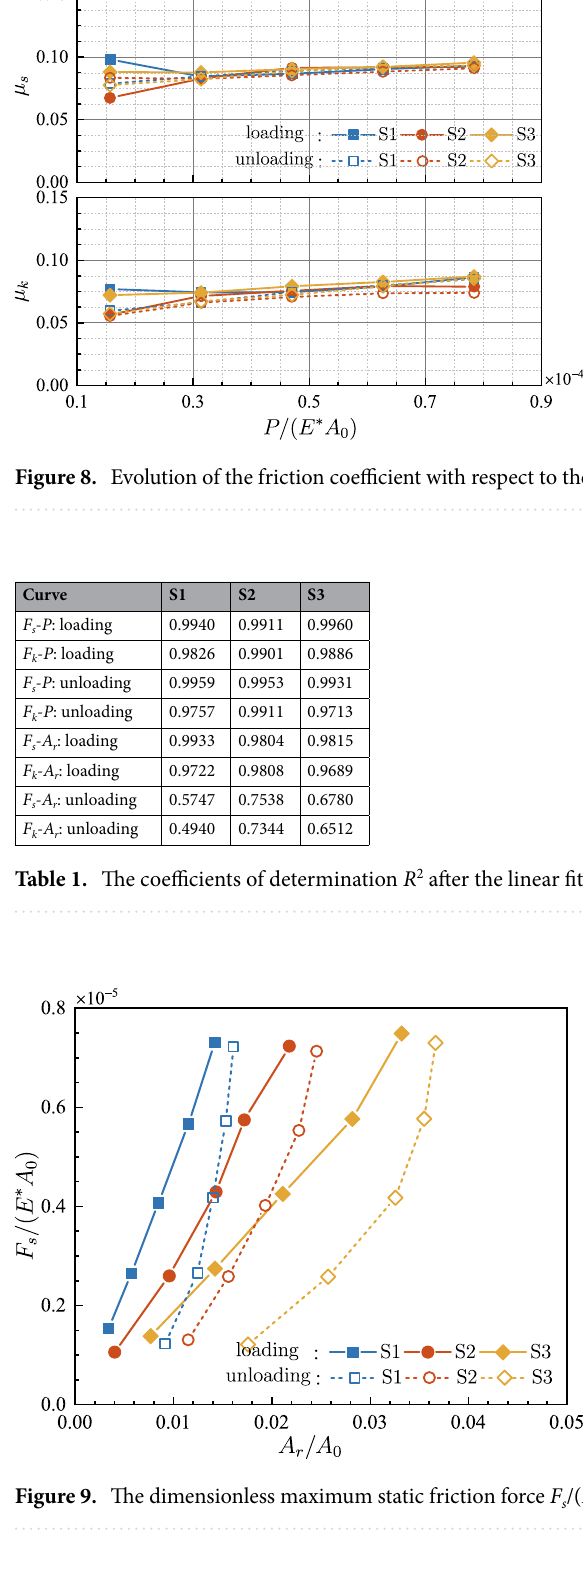
For both static friction and kinetic friction, the dimensionless mean tangential stresses F s /( GA r ) and F k /( GA r ) are calculated and denoted as τ s and τ k , respectively, with G = E /[2(1 + ν )] being the shear modulus. Figure 11 displays τ s and τ k at various normal loads for both loading and unloading. It can be seen that both τ s and τ k change slightly during loading, while decrease monotonously in the unloading stages. The slopes of the dimensionless mean tangential stress with respect to the dimensionless normal load of loading stages are much smaller than